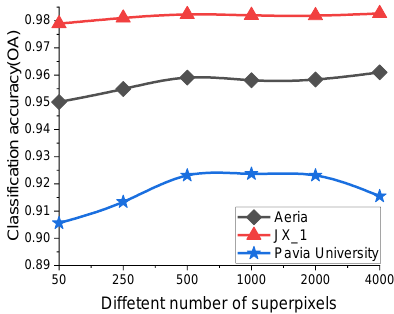
Figure 13. Classification results with different numbers of superpixels.